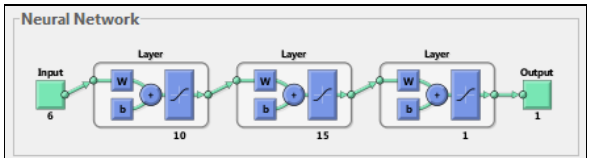
Figure7. Architecture of the neural network 3.3 Result The mean square error of the training data is 0.0229. Figure 8 shows the procedure of convergence of mean square error of training data.